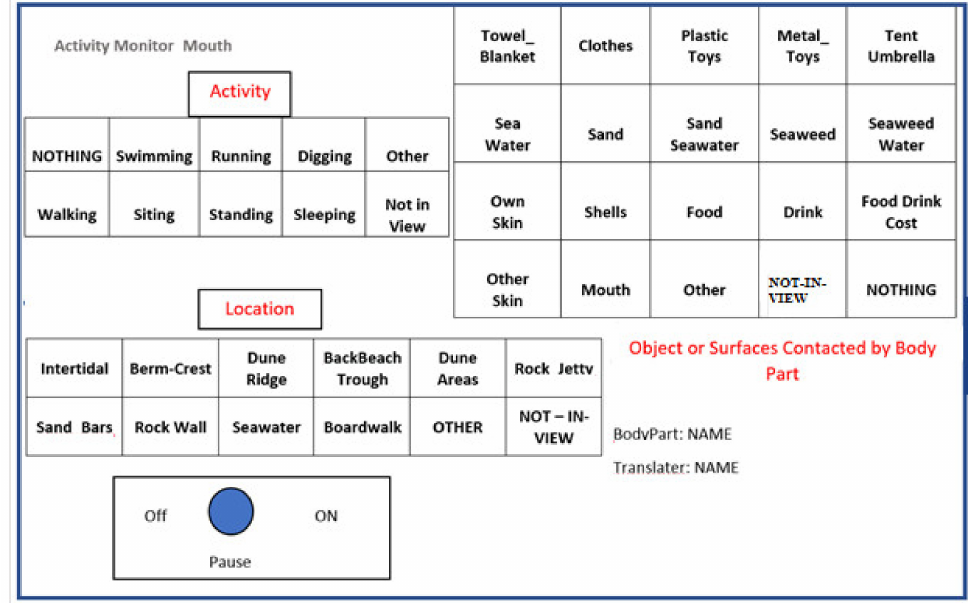
Figure 1. Virtual Timing Device Palette Used for Translation of Location, Activity, and Surface